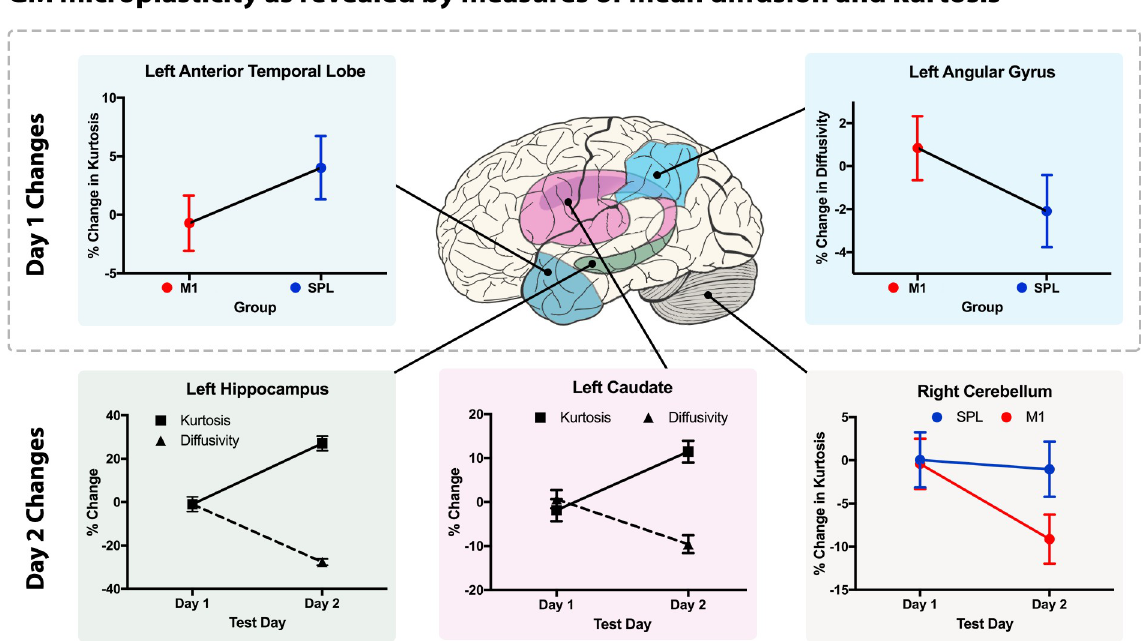
Fig 3. Results of ROI analysis. Statistically significant GM microplasticity as revealed by measures of mean diffusion and kurtosis changes (relative to baseline scan) evident already on the first follow-up scan (Day 1): In the control group, whose motoric learning was not impaired, there was an overall mean kurtosis increase in the left ATL and a diffusivity decrease in the left AG ROI (i.e., main effect of Group). Moreover, 24 hours after language learning (follow-up scan on Day 2), mean diffusivity and kurtosis differences were evident in the left caudate and left hippocampus in both learning groups (main effect of Test Day/Session). Finally, in participants who received disruptive M1 TMS, there was an overnight (after 24 hours) decrease in mean kurtosis in the right cerebellum, likely reflecting more effortful learning of action semantics through the cerebellar error-based encoding mechanism (Group × Day interaction). The above GM differences are relative to the pre-learning baseline measurements (i.e., they express percent change from the baseline). Error bars represent 95% confidence intervals. The data underlying this figure are provided on the Open Science Framework (https://osf.io/k9ngw). AG, angular gyrus; ATL, anterior-temporal lobe; GM, grey matter; ROI, region of interest; TMS, transcranial magnetic